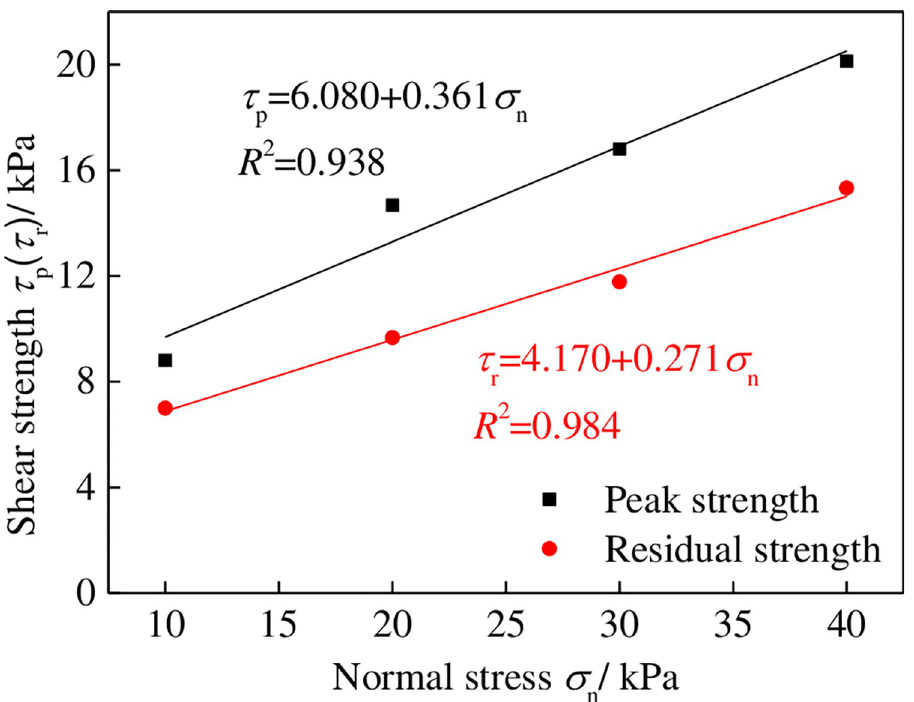
Fig 4. Relationship between friction strength and normal stress.